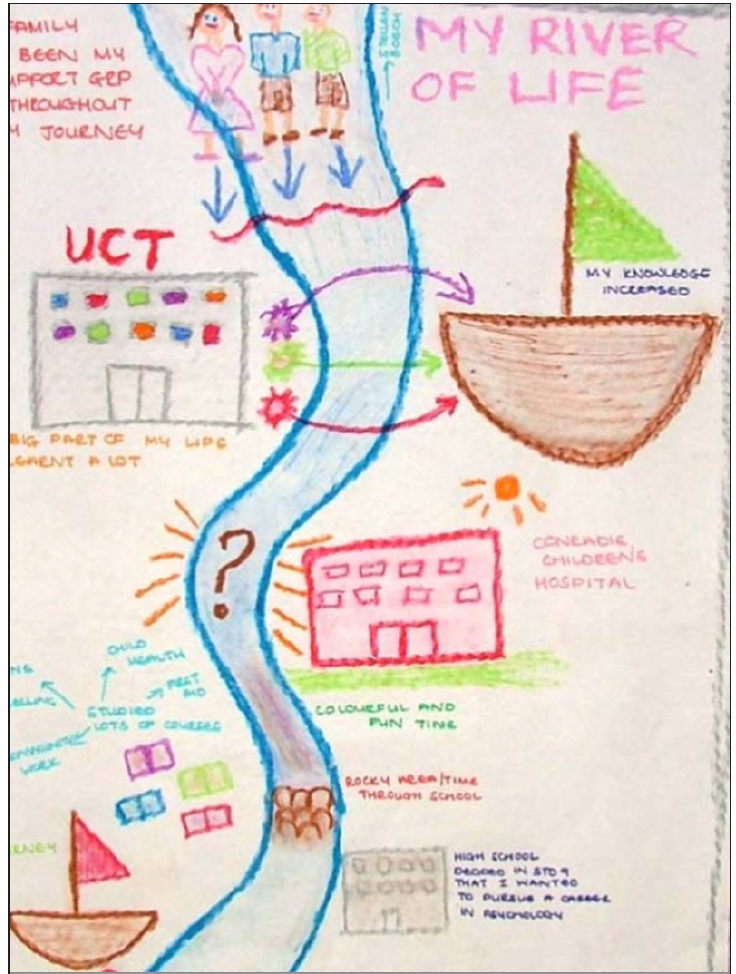
Figure 1 A typical river of